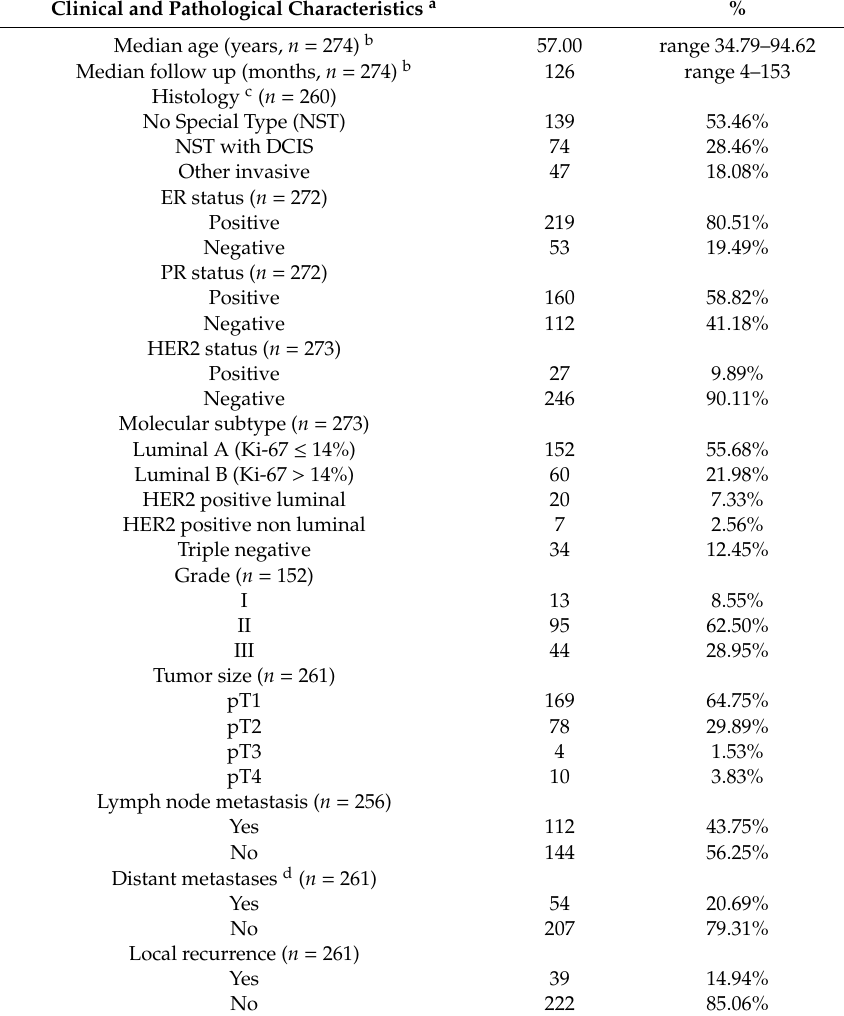
Table 1. Clinical and pathological characteristics of all